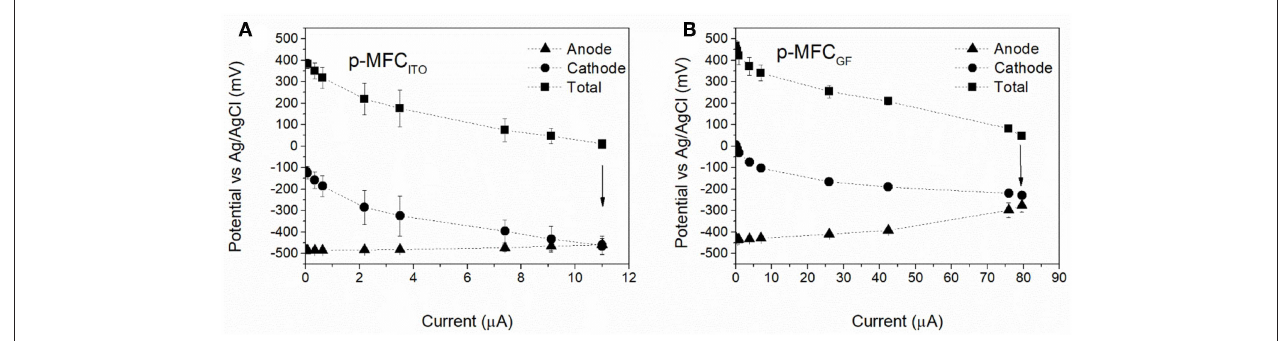
FIGURE 2 | Electrochemical characterization of the p-MFCs by polarization studies performed after 30 days of operation. (A) p-MFC ITO , (B) p-MFC GF . The fuel cells were left in OCV for 2h before the polarization studies. These were carried out after 5h from the beginning of the light cycle, when the current reaches a steady value. Arrows indicate the potential and current value under the external resistance of 510 (cid:127)